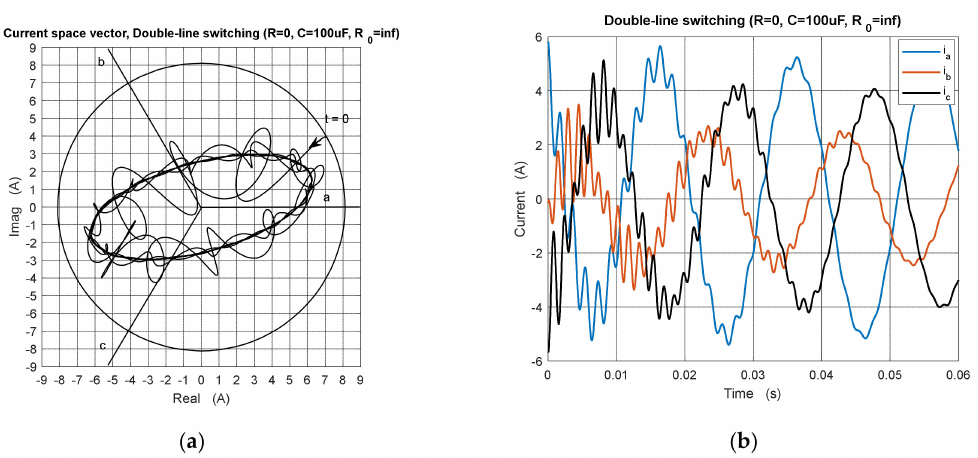
Figure 15. Double-line switching. Time-behavior of the current space vector ( a ) and the related phase currents ( b ) for the three-phase circuit in Figure 10 where S operates double-line switching of phases b and c with an impedance Z consisting of a capacitor C = 100 µ F. The single-phase circuit is open since R 0 → ∞